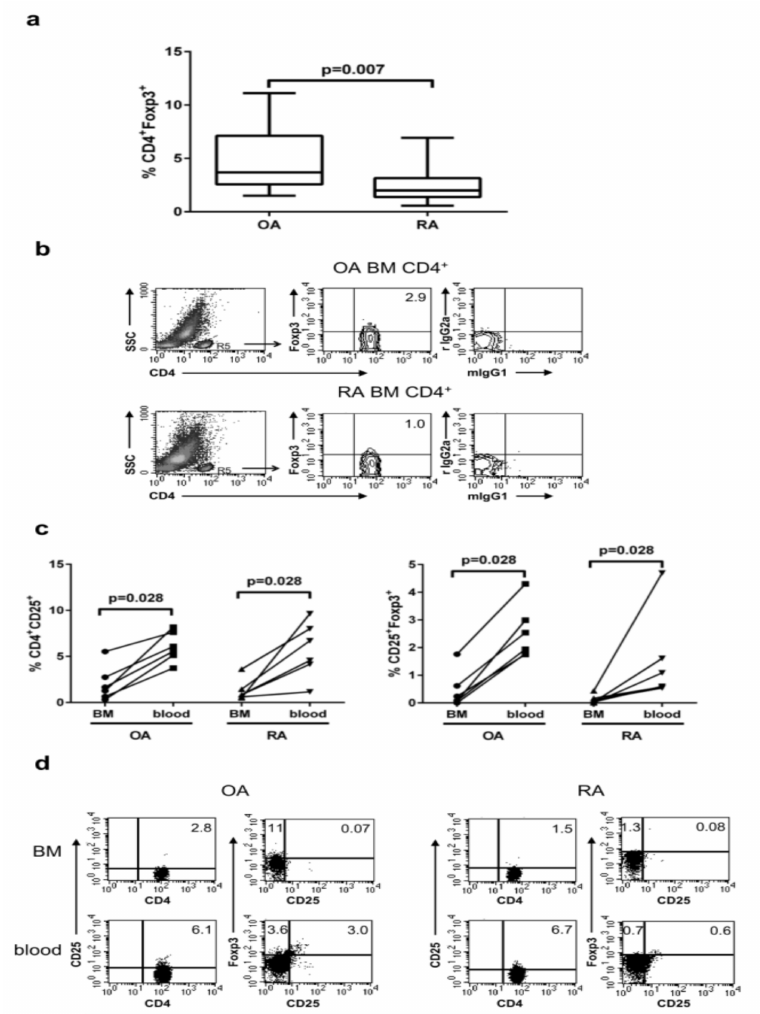
Figure 2. Analysis of CD4 + FOXP3 + T cells population in the BM. ( a ) Proportions of CD4 + FOXP3 +